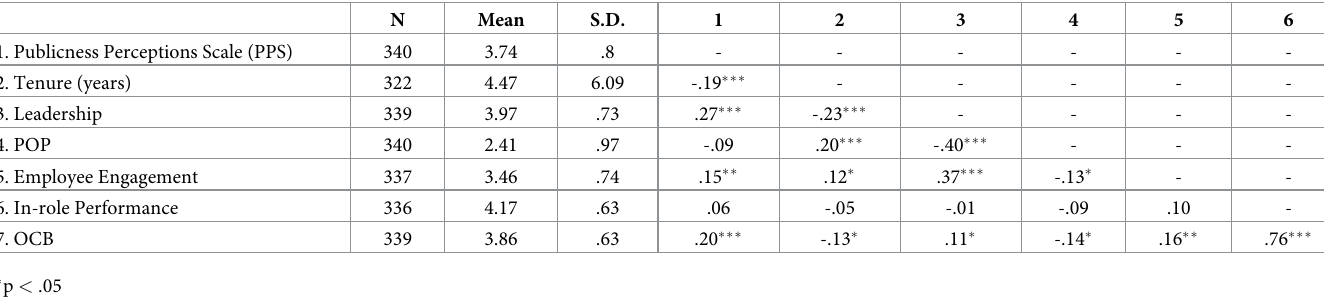
Table 1. Means, standard deviations, and